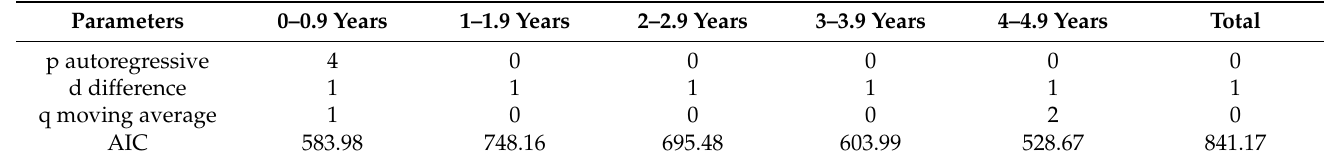
Table 1. Parameters of ARIMA models for febrile convulsion patients by